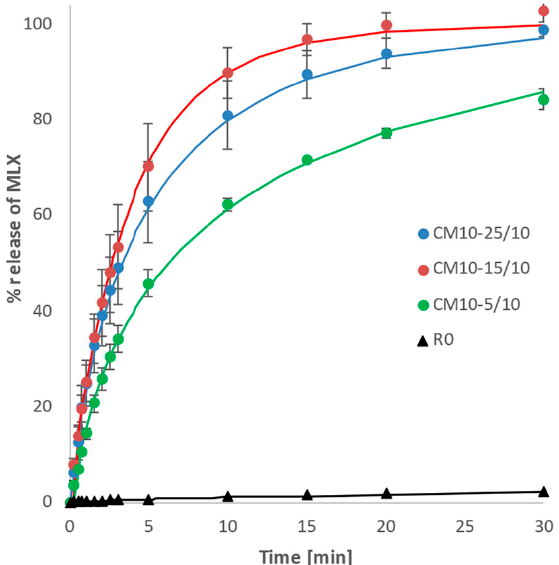
Figure 2. Dependence of MLX released on time for samples co-milled for 10 min with 10 mm balls and with SLS contents of 5, 15, and 25 wt.% and for the reference sample of pure MLX (R0). Experimental points fitted according to the Weibull model.